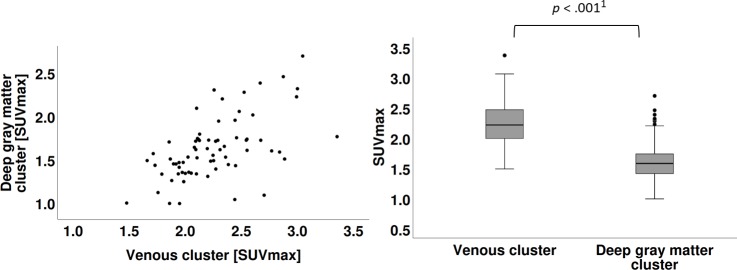
Scatterplots of SUVmax.A Scatterplot of SUVmax of venous cluster with SUVmax of deep gray matter cluster. B Significant difference in the SUVmax were found for venous cluster (M = 2.25, SD = 0.37) and deep gray matter cluster (M = 1.61, SD = 0.36), paired sample t-test, 1p = 1.0129E-24.